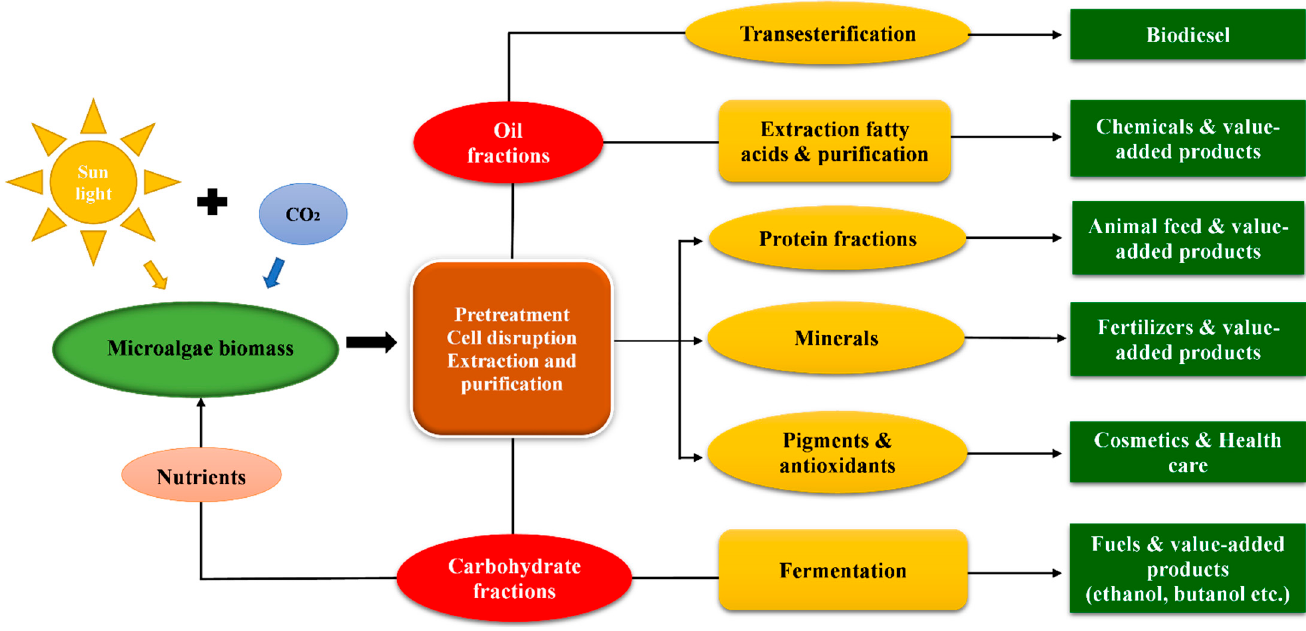
Figure 1. Possible microalgal biorefinery bioproducts. Table 1. Contents of macromolecules in various microalgae.